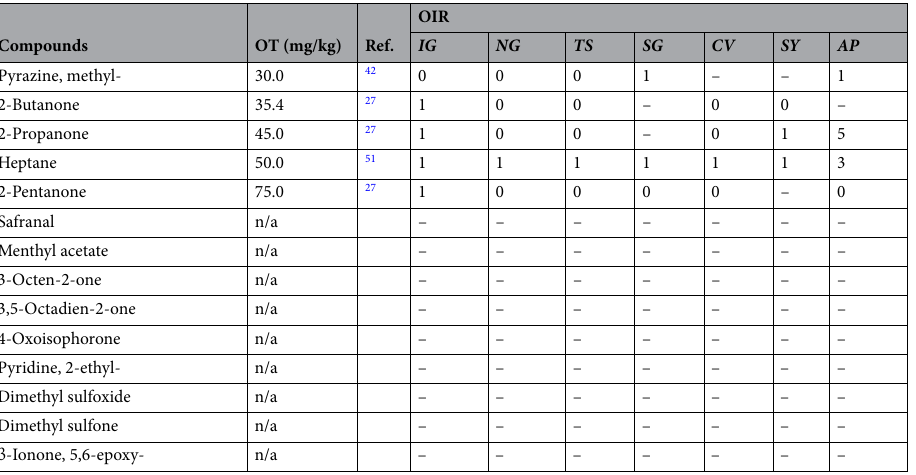
Table 3. Estimated mean odour impact ratio (OIR) values for volatile compounds detected in Isochrysis galbana (IG) , Nannochloropsis gaditana (NG), Tetraselmis sp. (TS), Scenedesmus almeriensis (SA) , Chlorella vulgaris (CV) Synechococcus sp ( SY ) and Arthrospira platensis ( AP ). OT odour thresholds in water, Ref. bibliographic reference, n/a not available bibliographic threshold.